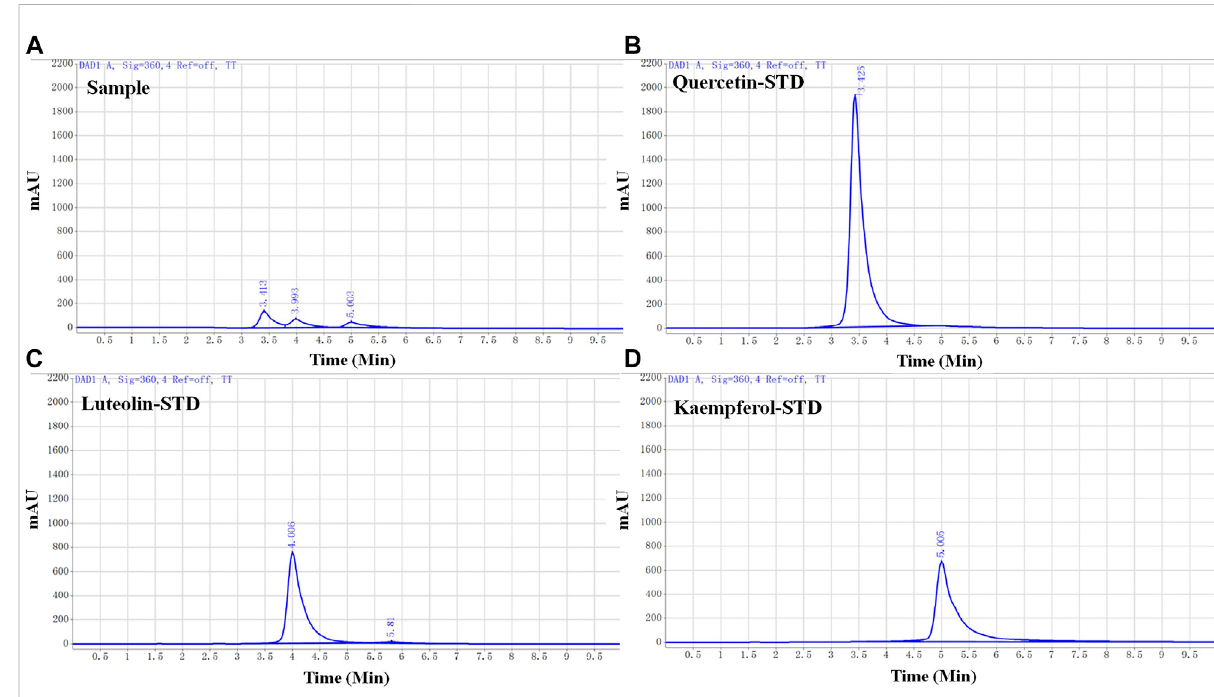
FIGURE 3 High-performanceliquidchromatography(HPLC)chromatogramsofhoneysuckle-forsythiawaterextractandeachactiveingredient. (A) HPLC chromatogram of honeysuckle-forsythia water extract. 1: Quercetin, 2: Luteolin, 3: Kaempferol. (B) Quercetin. (C) Luteolin. (D) Kaempferol.